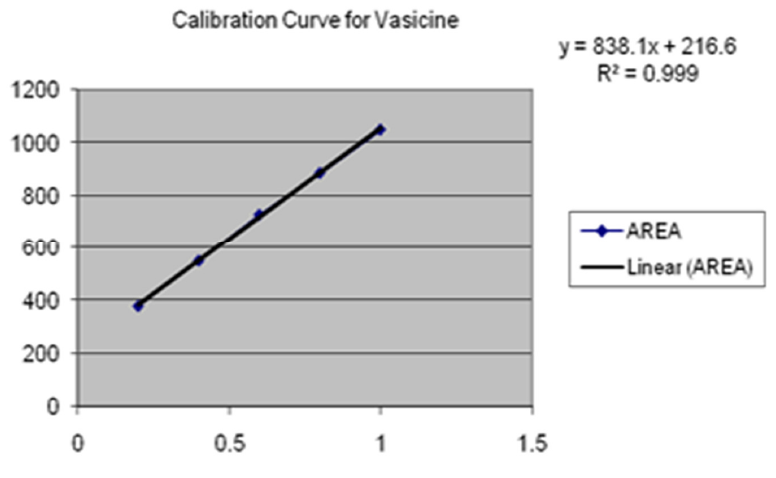
Figure 3. Calibration curve of